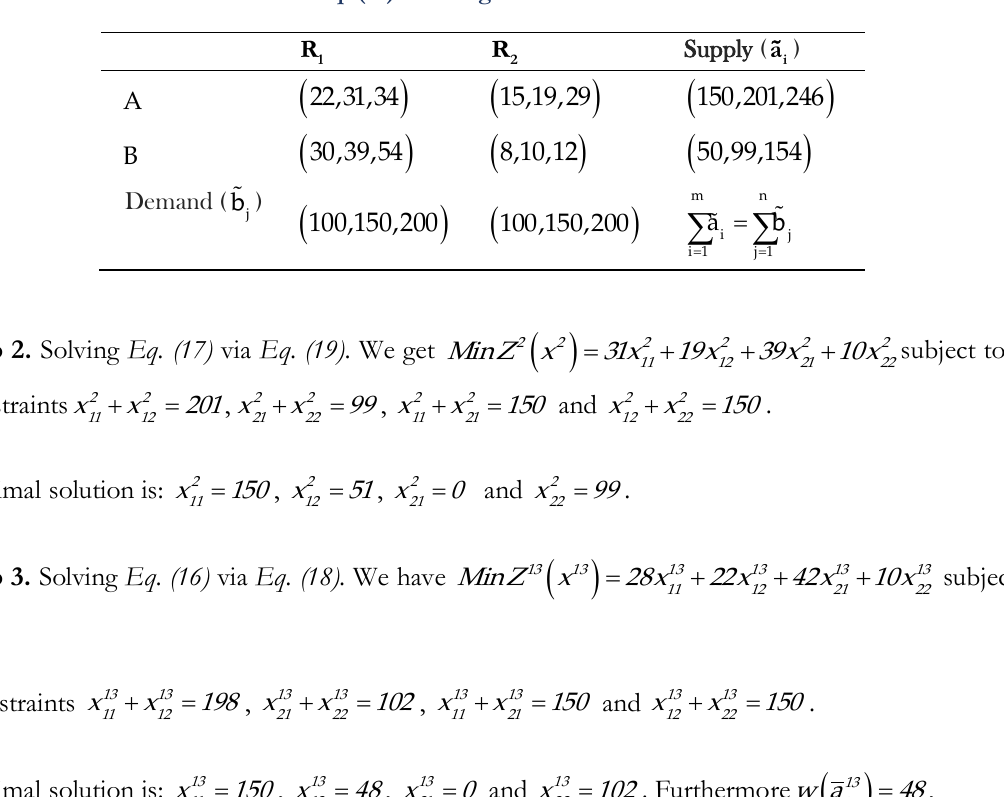
Table 3. Eq. (15) in triangular balanced